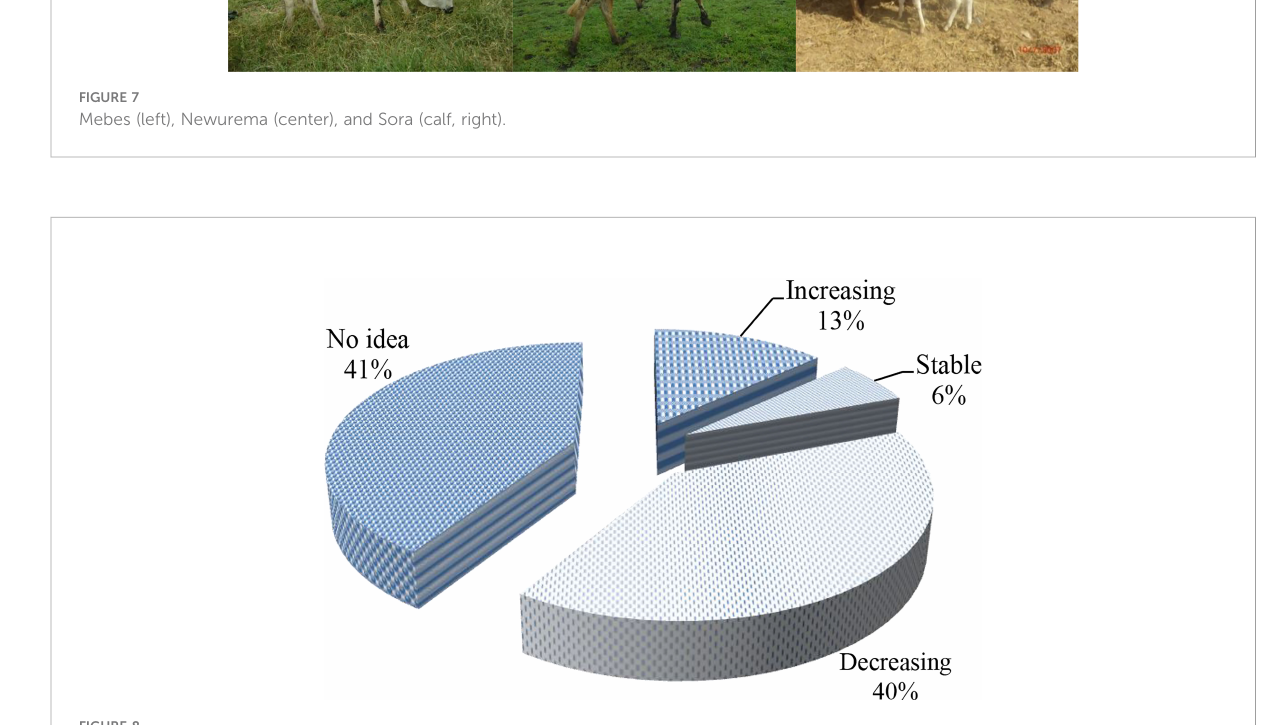
FIGURE 8 Trends of the Fogera cattle population.